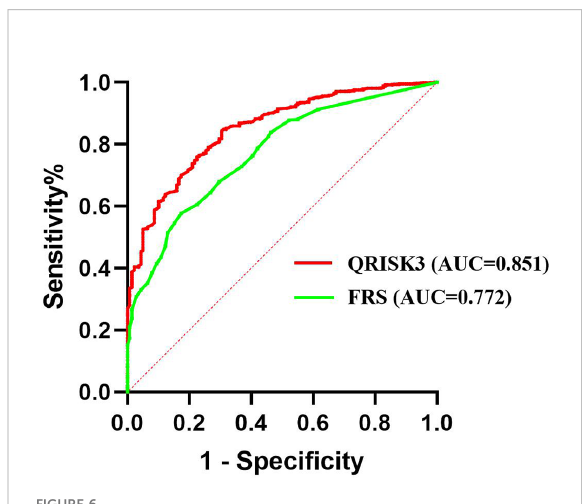
FIGURE 6 ROC for QRISK3 and FRS (patients with loss to follow-up were classi fi ed as non-CVD groups). Legend: All the patients who lost to follow-up were classi fi ed as non-CVD group. ROC, Receiver operating characteristics; AUC, area under the ROC curve; QRISK3, QRESEARCH Risk estimator version 3; FRS, Framingham risk score; CVD, cardiovascular disease.